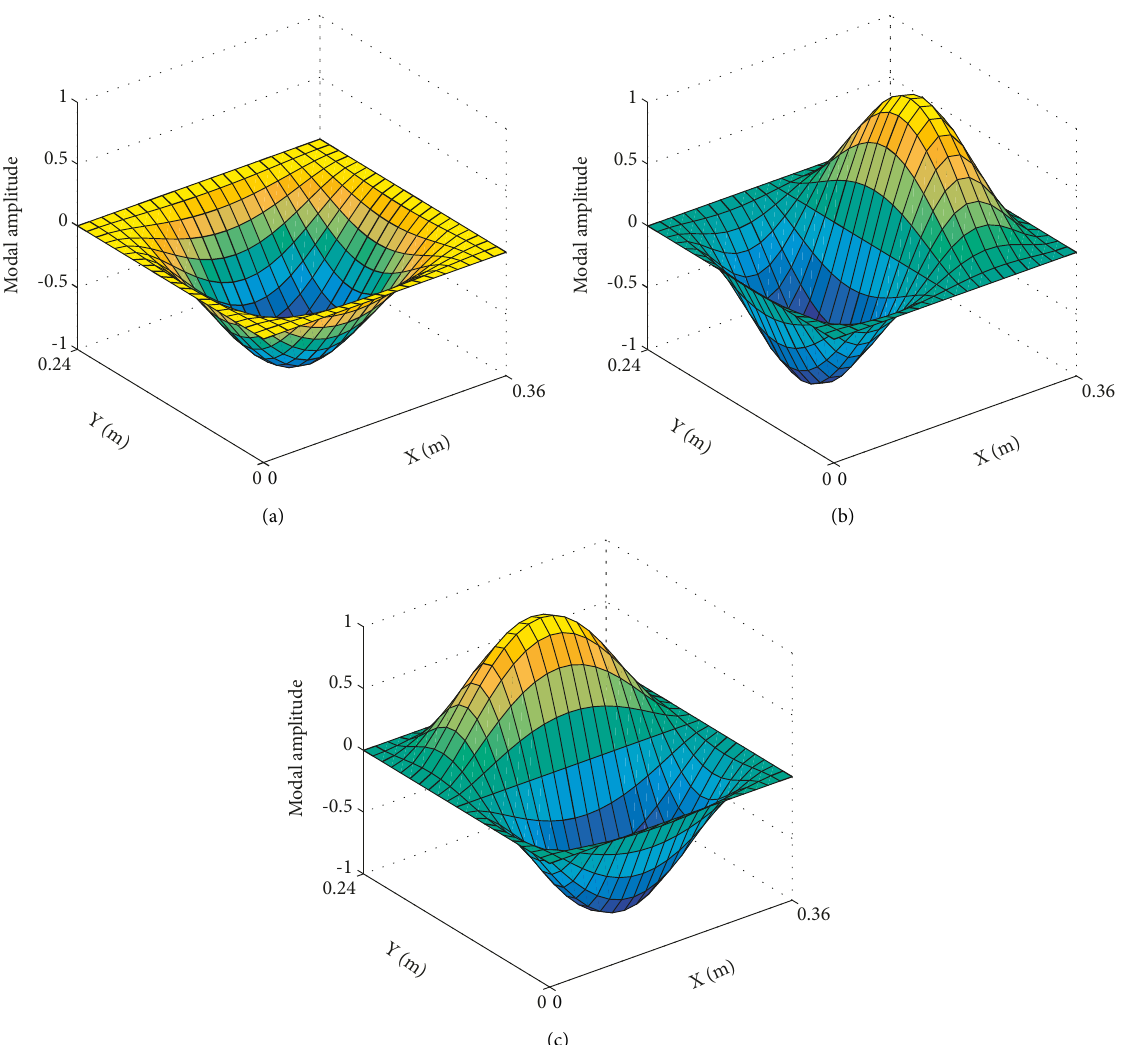
Figure 13: The first three flexural mode shapes of the undamaged plate, fixed boundary conditions: (a) Mode 1, (b) Mode 2, and (c) Mode